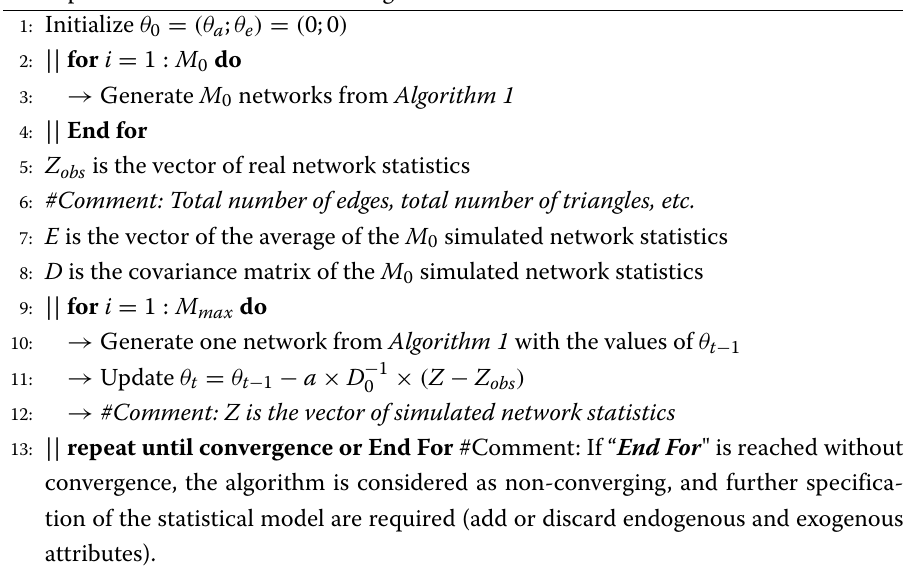
Algorithm 2 The stochastic approximation algorithm: This algorithm updates the